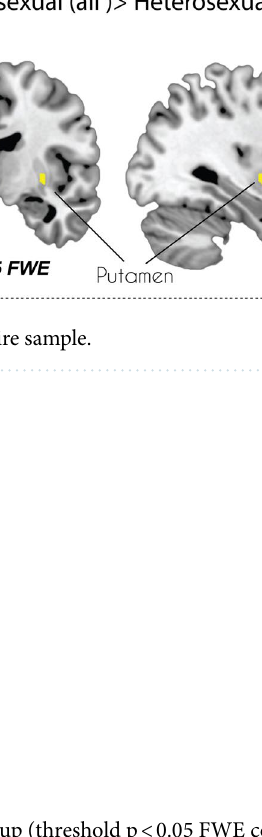
Table 1. Cluster list for contrast heterosexual > homosexual all group (threshold p < 0.05 FWE corrected at voxel level). L/R left/right in the brain; s.c. sub-cluster, SFG Superior Frontal Gyrus; MTG Middle Temporal Gyrus.